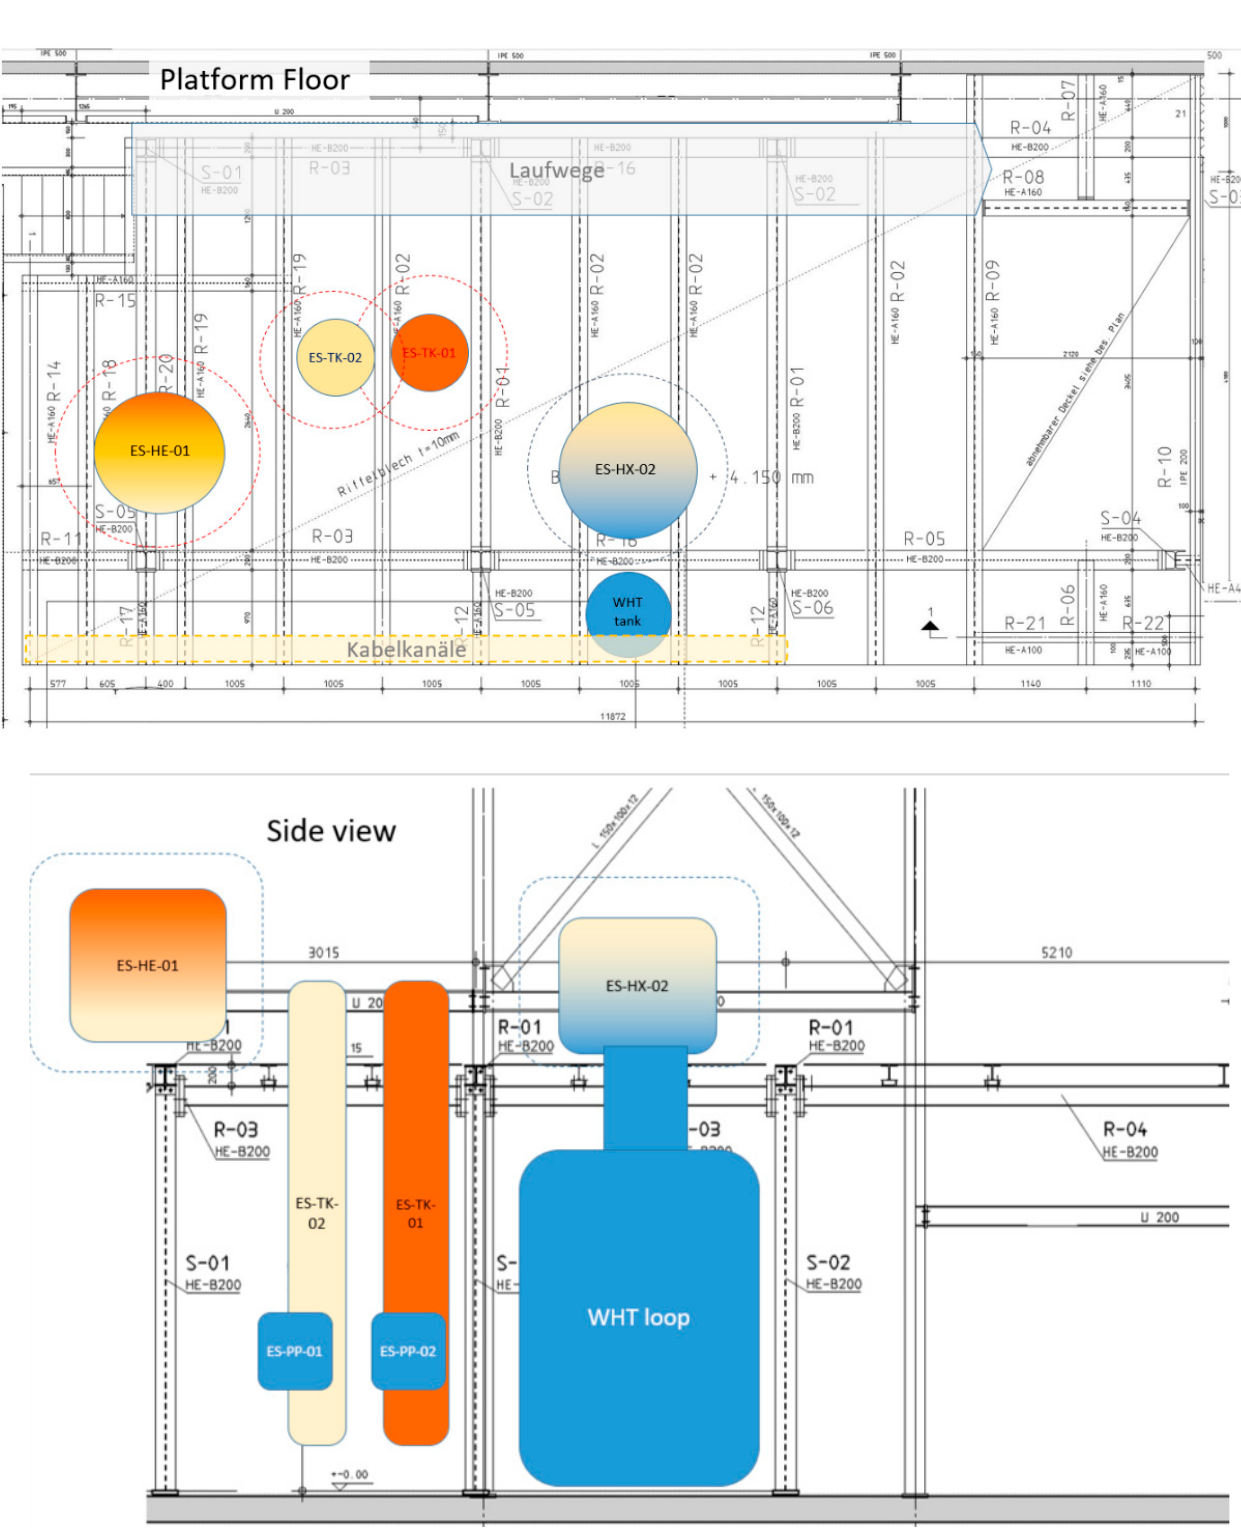
Figure 6. Location of ES components. Top: top view at the 4 m-platform. Bottom: side